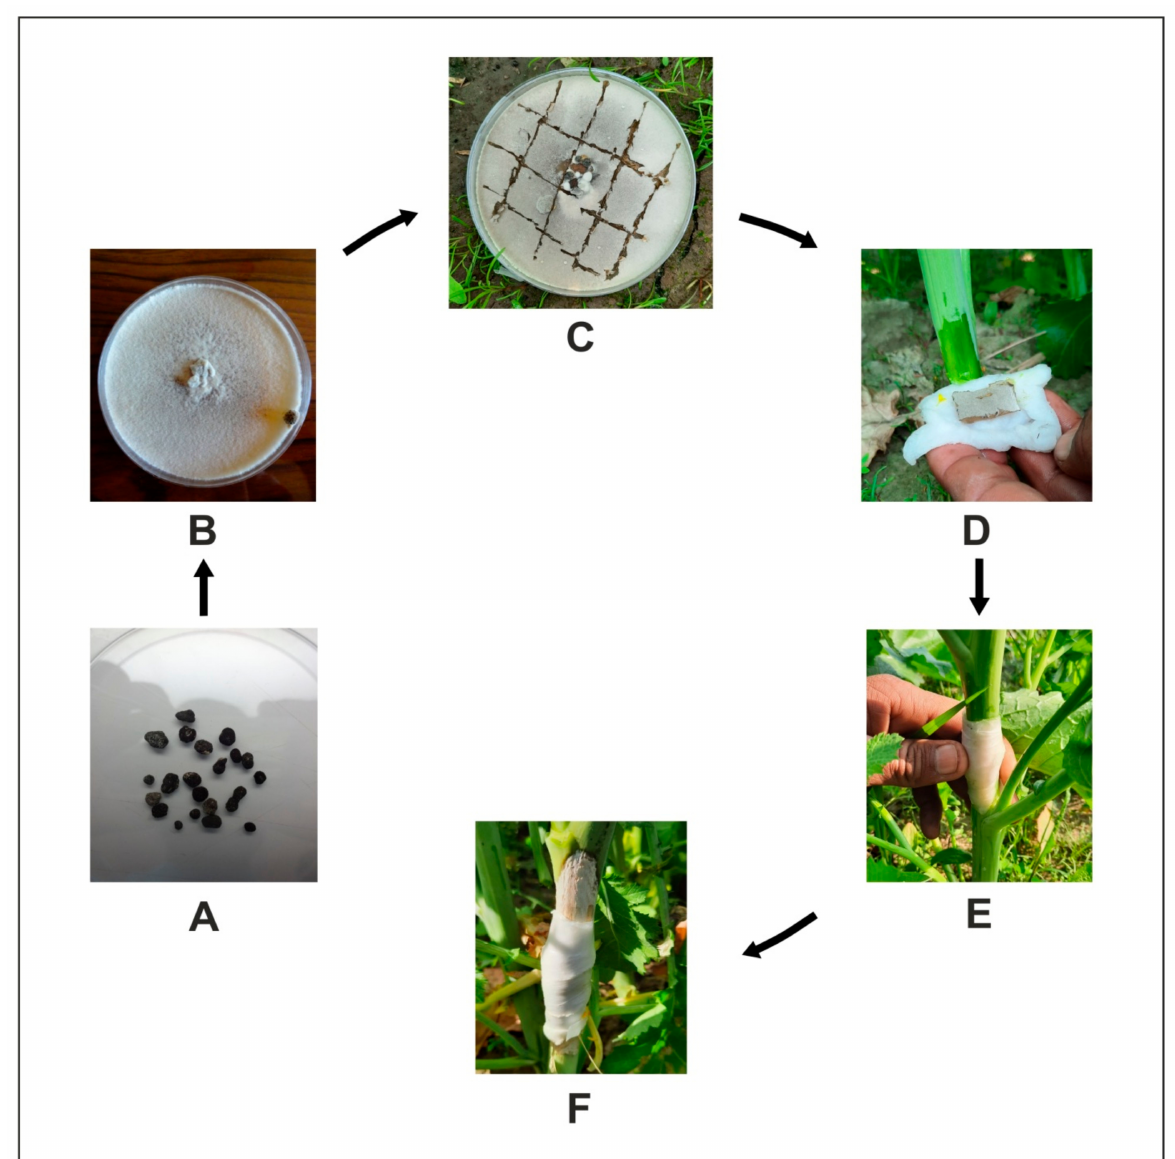
Figure 2. Sclerotinia sclerotiorum pure culture preparation and artificial stem inoculation; ( A ) sclerotial samples were surface sterilized with 0.1% mercuric chlorite solution; ( B ) 5-days-old pure culture of S. sclerotiorum; ( C ) 5 mm mycelial bits cuts from 5-days pure culture of S. sclerotiorum ; ( D ) single mycelial bit along with cotton swab soaked in sterilized distilled water; ( E ) wrapping the parafilm strip around the stem; ( F ) inoculated plant showed characteristics symptoms of water-soaked lesion.